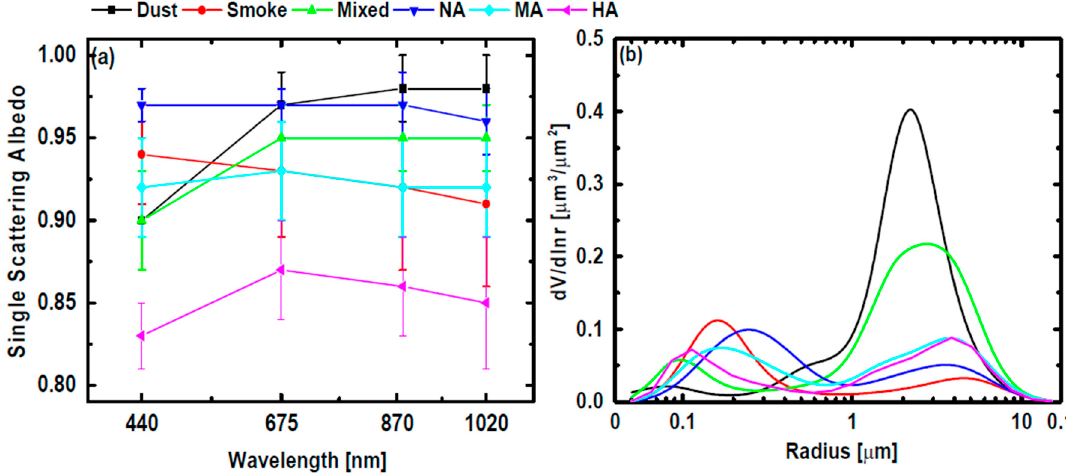
Figure 3. Mean values of spectral ( a ) single scattering albedo and ( b ) particle size distribution for dust (black), smoke (red), mixed (green), non-absorbing pollution (blue), moderately-absorbing (cyan) and high-absorbing (magenta).